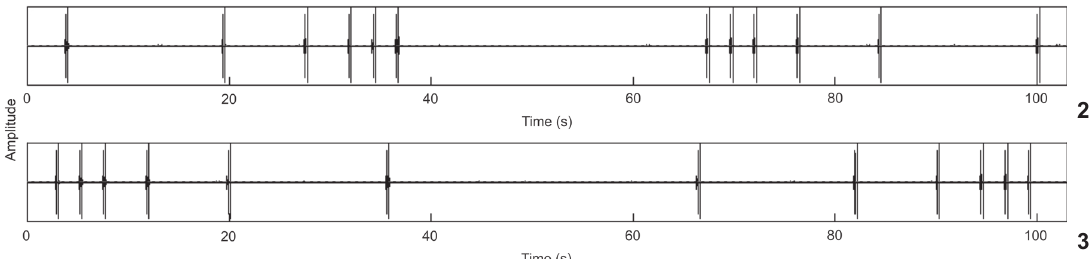
Figures 2-3. Design of the playback experiments conducted at the Floresta Nacional de Silvânia, municipality of Silvânia, state of Goiás, Brazil: (2) sequence A playback experiment; (3) sequence B playback